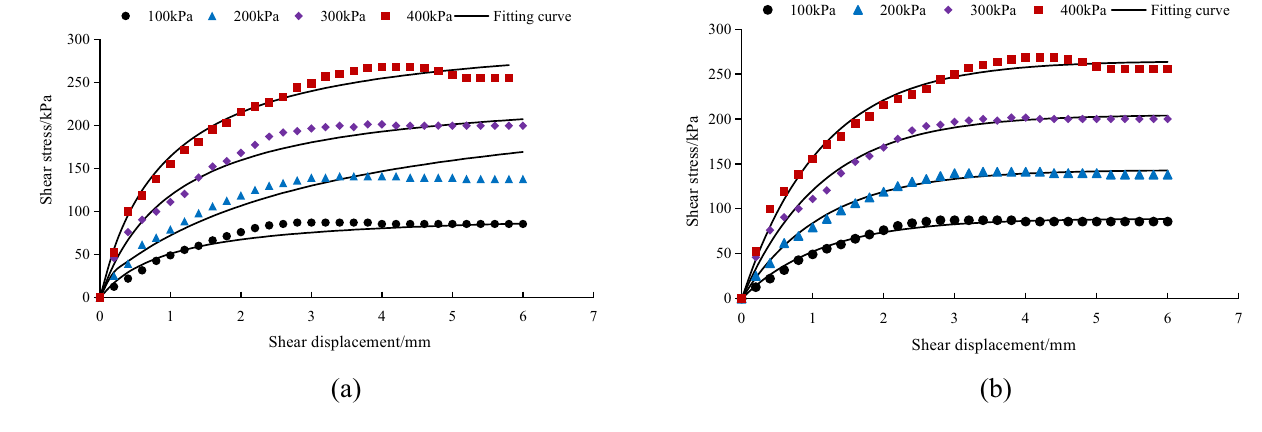
Figure 9. Fitting curve of RS interface model. ( a ) The Clough–Duncan curve model; ( b ) the improved Gompertz curve model.